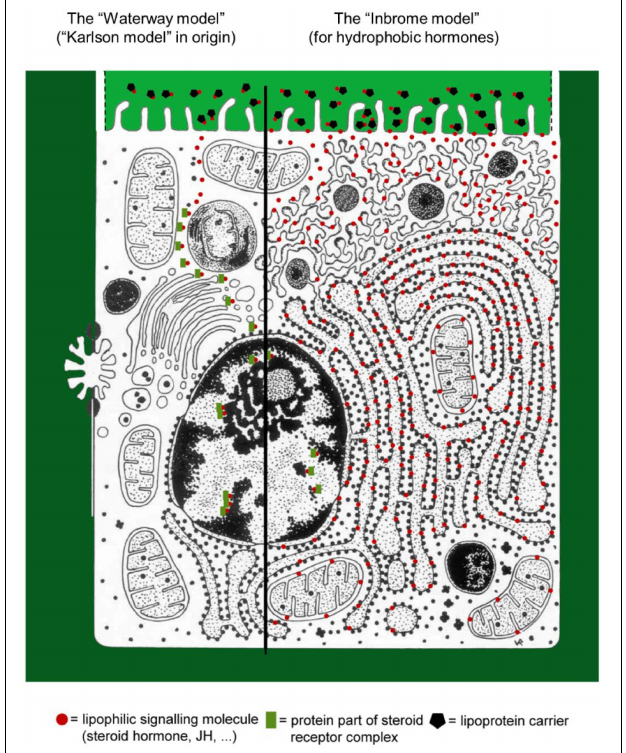
FIGURE 4 | Two models for the entry and intracellular transport of small non-proteinaceous/peptidic hormones in cells. (Left panel) According to Karlson and Sekeris (1966) the ecdysteroid molting hormone of insects (20-hydroxy ecdysone or 20E), which is moderately water-soluble, could pass the plasma membrane by simple diffusion without eliciting any signaling (e.g., through Ca 2 + ) at the level of this membrane. Next, it would diffuse through the cytoplasm and end up in the nucleus. Here, it would (in)activate specific genes. In the 1960s–1970s, this concept was expanded toward being also valid for lipohilic/hydrophobic molecules such as some vertebrate-type sex steroids and to insect juvenile hormone(s). Later, this model got complemented with cytoplasmic protein transporters for the transport of lipophilic/hydrophobic molecules through the cytoplasm into the nucleus. This model, despite justified criticisms, is still widely used to date. (Right panel) The “intramembrane transport model” or “inbrome model.” In particular for hydrophobic small hormones, e.g., the juvenile hormone esters of farnesol, the inbrome mode of action model was originally advanced by De Loof (2015). It says that such hydrophobic hormones are transported in the blood/hemolymph by a lipoprotein that delivers the hormone at the plasma membrane, in which the hormone will enter through hydrophobic interaction. Next, the hormone will start diffusing through the entire system of all connected membrane systems: plasma membrane, smooth endoplasmic reticulum (SER)–rough endoplasmic reticulum (RER), nuclear envelope, Golgi apparatus, mitochondria, etc. These lipid bilayer membranes are liquid and act as a solvent and transport system for hydrophobic molecules. During the diffusion, the hydrophobic molecules will encounter many proteins that are anchored in the membranes. They all have hydrophobic transmembrane stretches of amino acid chains. Some membrane proteins may act as genuine receptors. The interaction with actors of the Ca 2 + homeostasis system is important. The lighter green color at the top of this figure does not mean that here the Ca 2 + concentration is lower, but to make the details readable. Intracellular Ca 2 + gradients ( Figure 1 ) are not represented. Own work, modified after De Loof (2017a, Open Access): Copyright permission